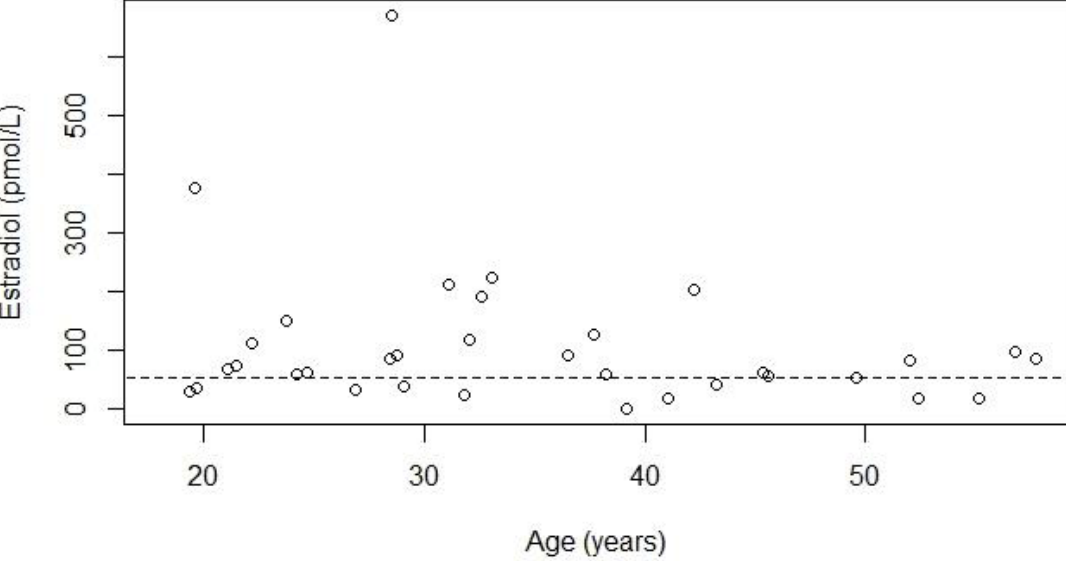
Figure 2. Relationship between serum estradiol concentrations and age for 34 women with Prader-Willi syndrome. The dotted line represents the lower limit of normal for estradiol of 55 pmol/L. Thirty-three women included in this figure had hypogonadism. One woman did not have hypogonadism as she had a regular menstrual cycle, she had an estradiol value of 41 pmol/L. The p -value for the relationship between estradiol and age was 0.27, Kendall’s Tau was −0.13.